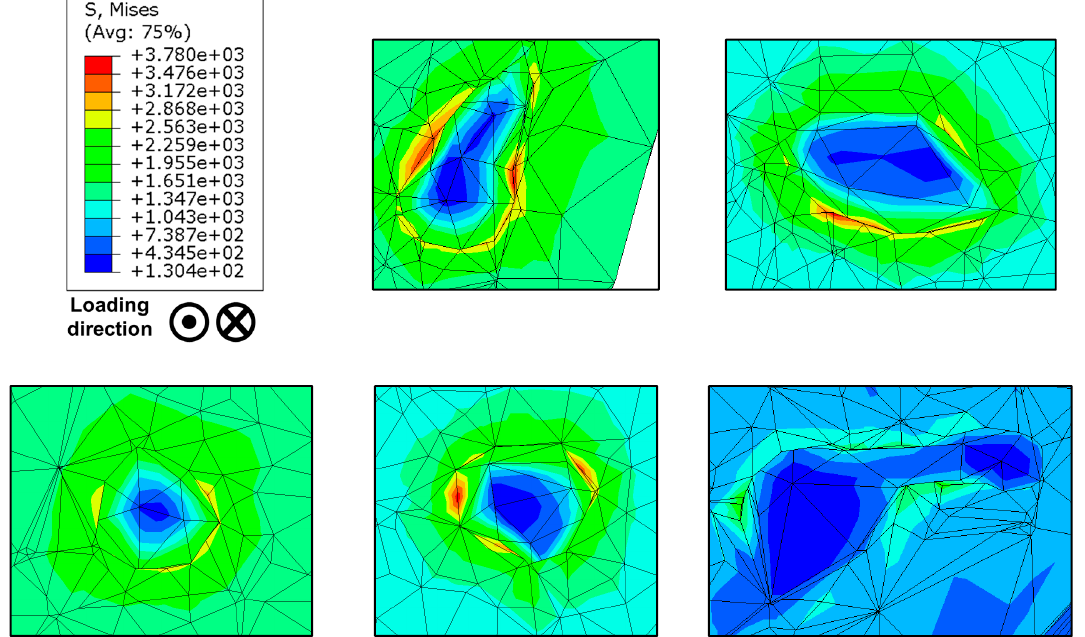
Figure 9. Stress distribution at multiple pores inside Ti-6Al-4V specimen cyclically loaded at stress ratio R = − 1 and stress amplitude σ a = 800 MPa.